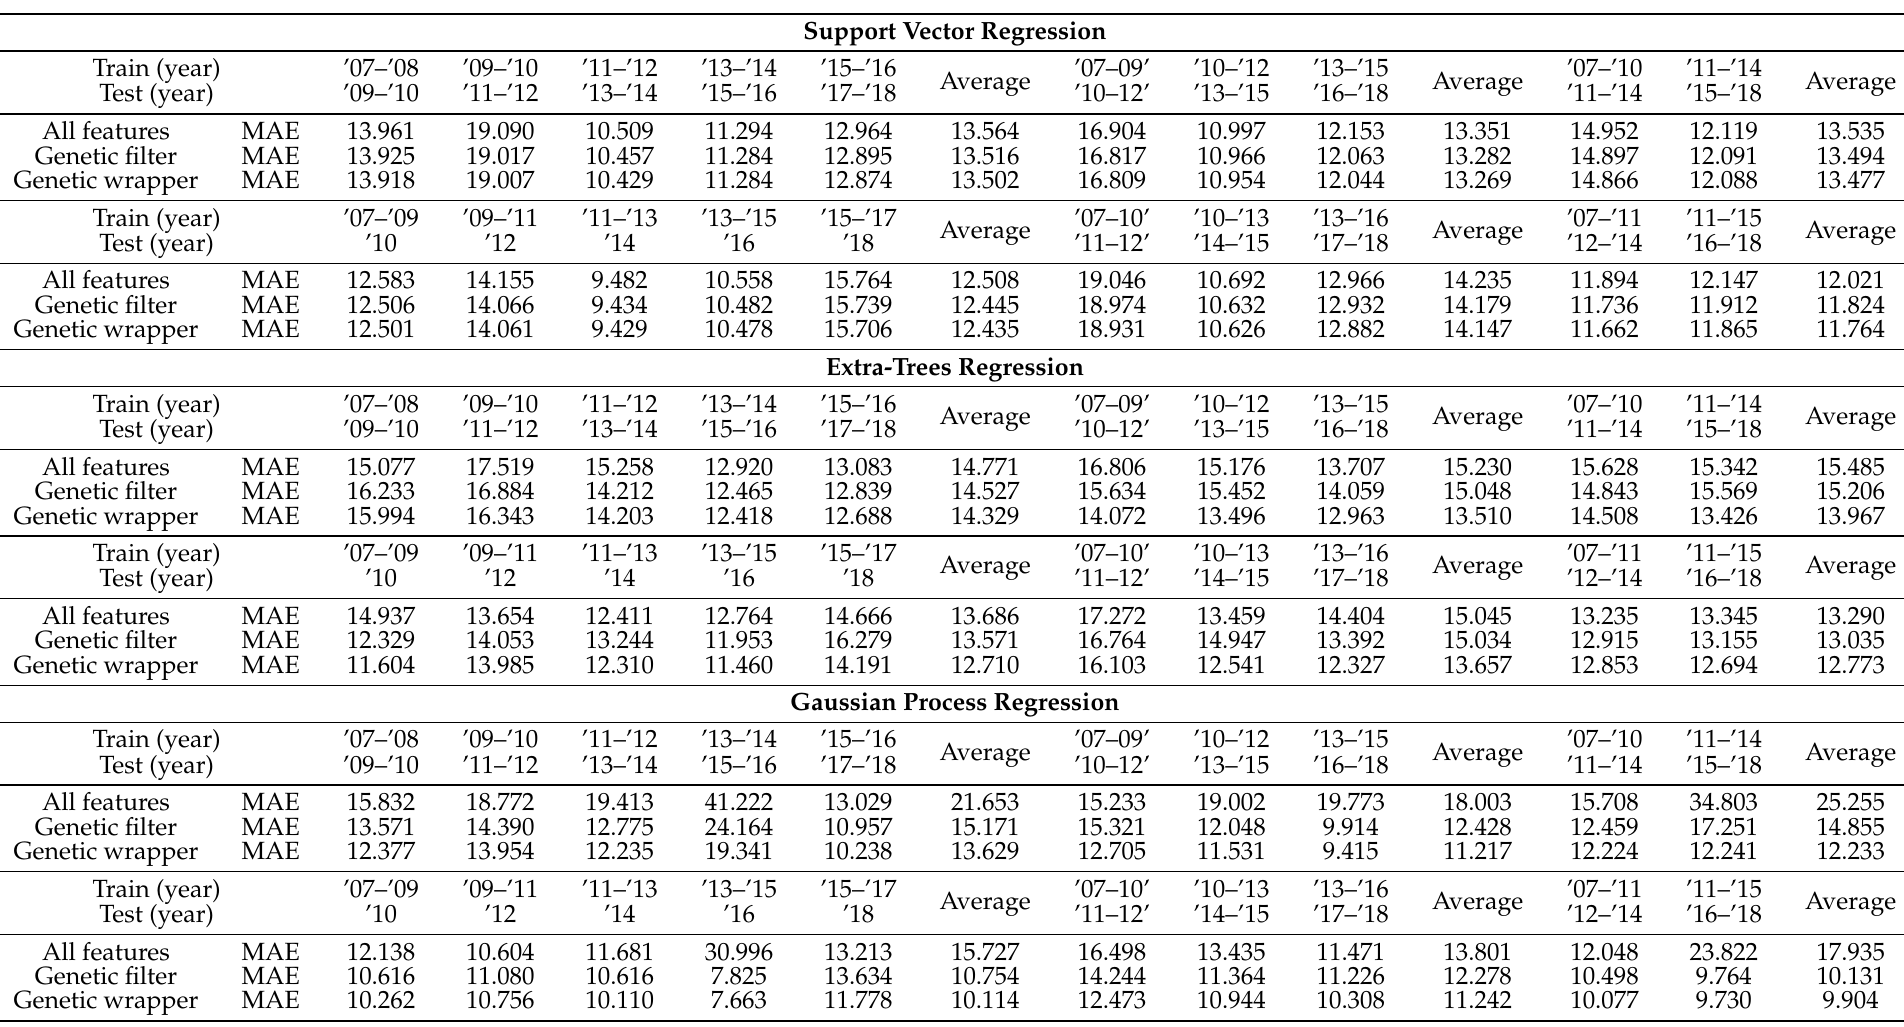
Table A3. Results of applying feature selection to the percentage changes of